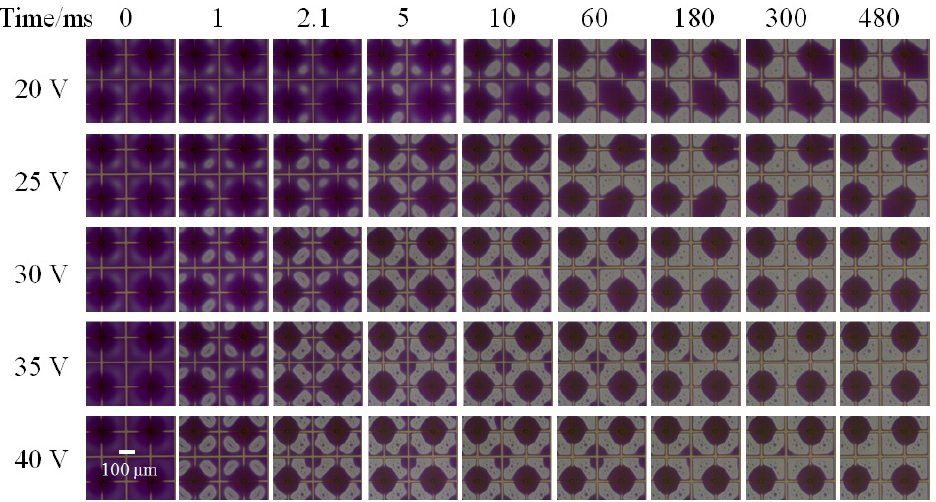
Figure 4. The oil–water state graphs with time at different voltages. The voltage is 20 V, 25 V, 30 V, 35 V, and 40 V from top to bottom. The spacer height is 60 μ m and the spacer density is 1:4. The time of 0 ms is set as the time oil film rupture starting.